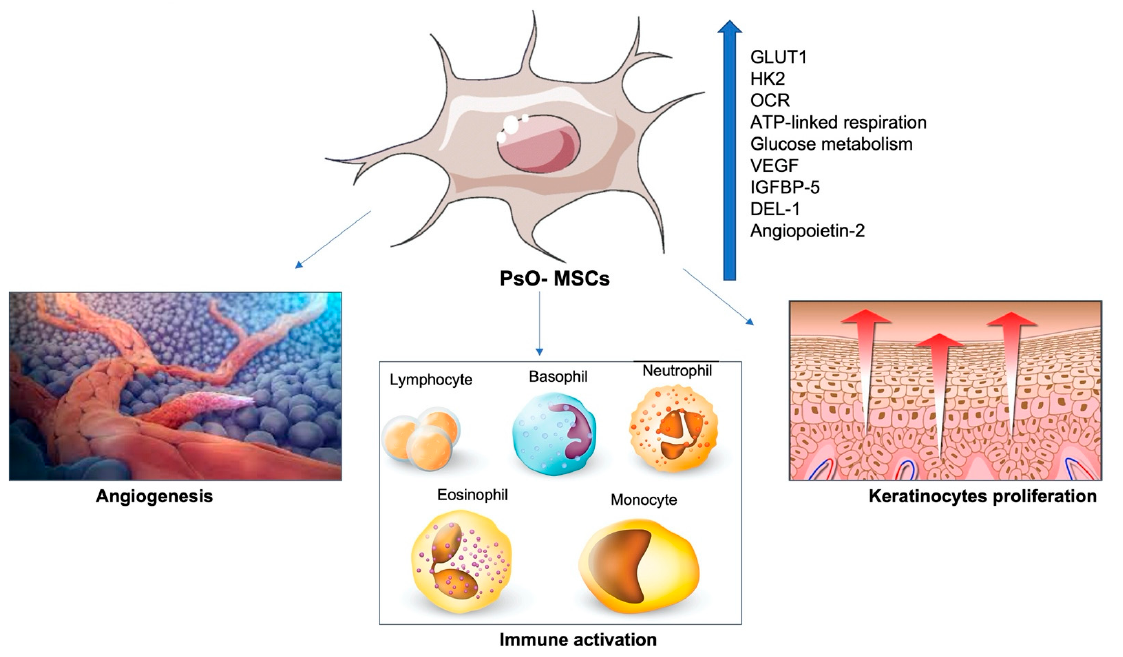
Figure 3. Effects of PsO-MSCs on the vascularization of psoriatic lesions: upregulation of GLUT1, HK2, OCR, ATP-linked respiration, glucose metabolism, VEGF, IGFBP-5, DEL-1 and angiopoietin-2 in dermal PsO-MSCs promotes immune activation, keratinocytes proliferation, and angiogenesis in inflamed skin.